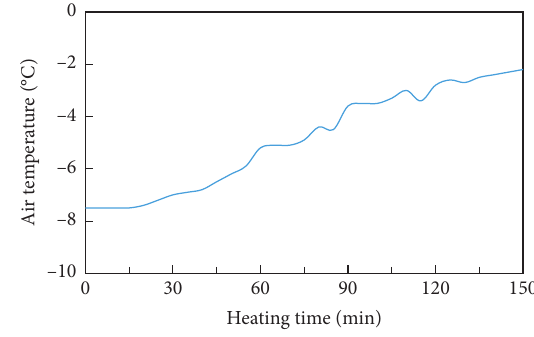
Figure 2: Air temperature variation.